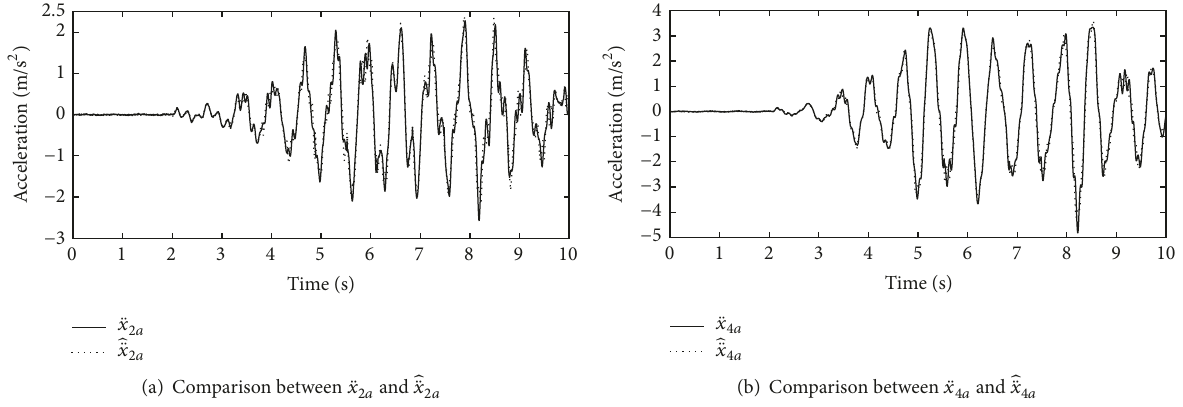
̂̈𝑥 ̂̈𝑥 2𝑎 and 4𝑎 corresponding to the distribution